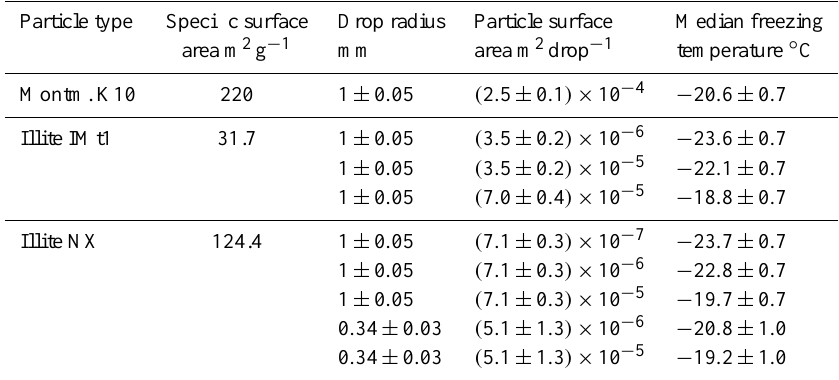
Table 1. Experimental conditions during freezing